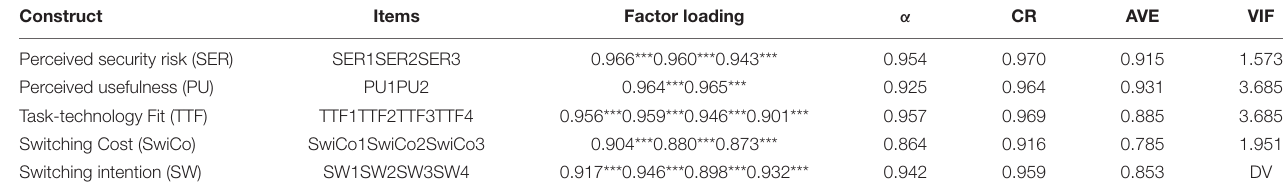
TABLE 1 | Research topics on the push-pull-mooring (PPM) theory. Construct Items